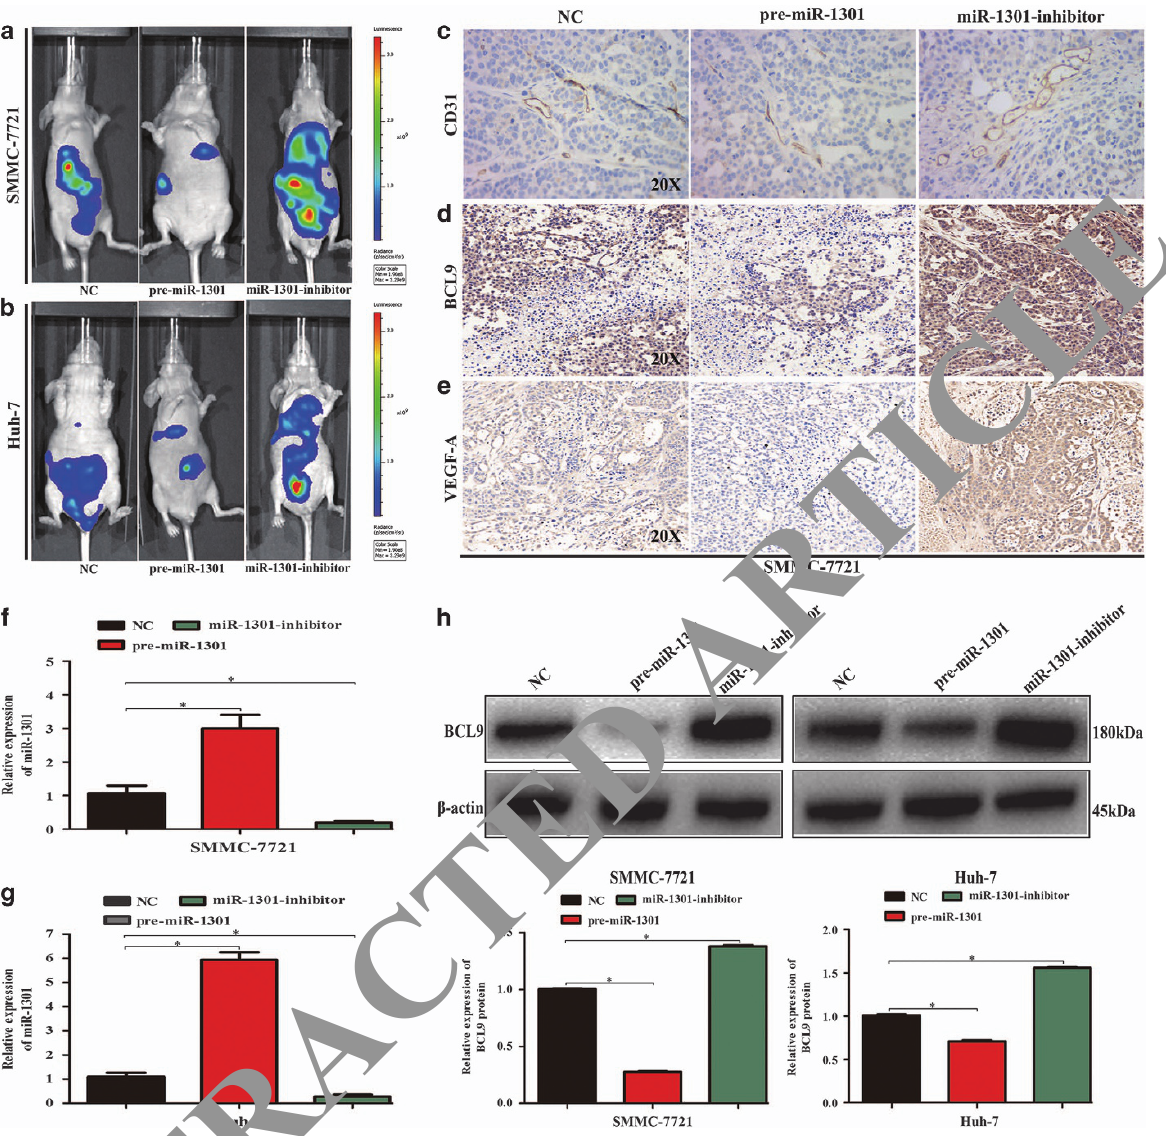
Figure 7 miR-1301 overexpression suppressed HCC metastases in vivo . ( a and b ) Photographs of tumors were taken by the IVIS Imaging System (Caliper Life Science, Hopkinton, MA, USA). A representative luciferase signal was captured in each group 6 weeks after injecting SMMC-7721 and Huh-7 cells with negative control, miR-1301 overexpression and miR-1301 knockdown. ( c – e ) CD31, BCL9, and VEGF-A expression were analyzed in tumor tissues by immunohistochemistry; representative images are shown at ×20 magnification. Blood vessels were stained using anti-CD31 antibodies, and positively stained blood vessels were counted in five areas per slide to determine the maximum number of microvessels; 10 slides per experiment. The results are presented as mean ± S.D. values. ( f and g ) The levels of miR-1301 expression in the metastatic tumors derived from nude mice were measured by qPCR. ( h ) The levels of BCL9 protein expression in the metastatic tumors derived from nude mice were measured by western blotting. * P o